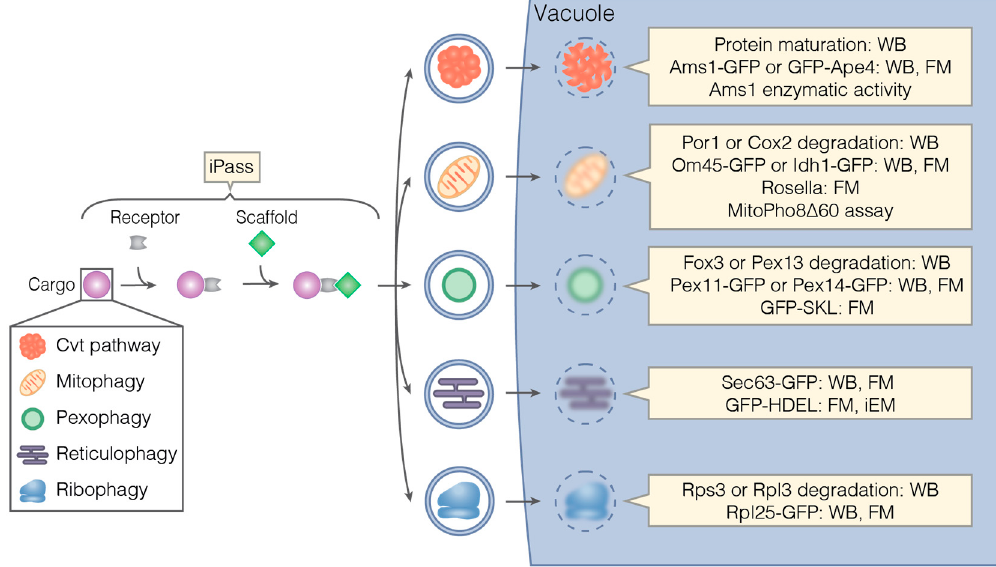
Figure 4. Methods for studying different types of selective autophagy. iPass is a versatile tool to investigate early events in selective autophagy, but can be applied to many other questions as well—see Figure 6B for details. Many methods to study selective autophagy are based on degradation of cargo-specific proteins, vacuolar delivery of fluorescently tagged cargo structures, enzymatic assays or electron microscopy—see text for details. While ribophagy is a selective autophagy pathway, no cargo receptor for ribosomes has been identified yet. FM: fluorescence microscopy; iEM: immuno-electron microscopy; WB: Western blotting.